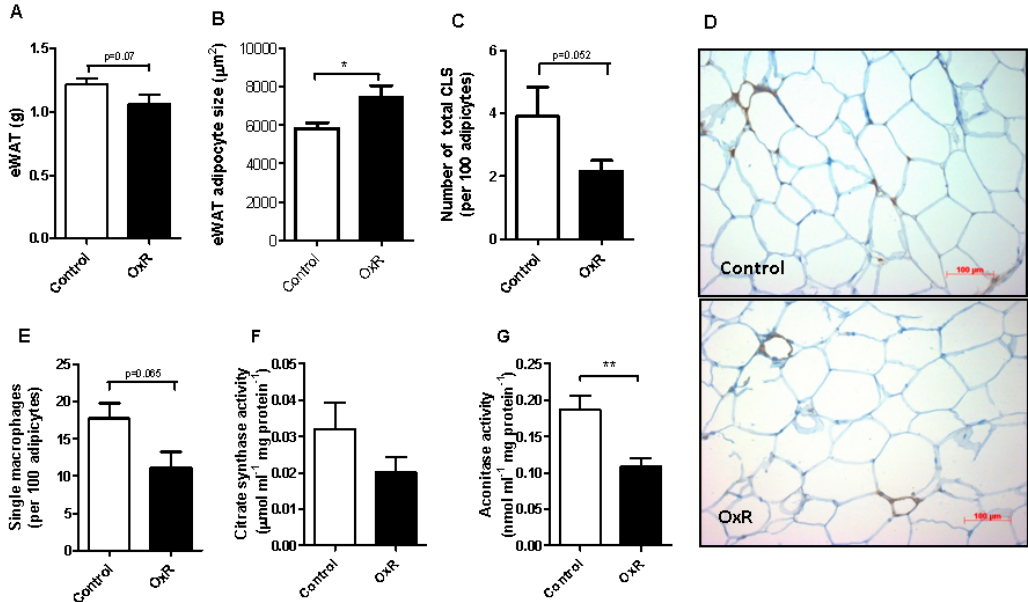
Figure 3. White adipose tissue (WAT) histology and inflammation. Epididymal white adipose tissue ( A ) weight, ( B ) mean adipocyte cell area, ( C ) number of crown-like structures (CLS) assessed by quantification of MAC-2 staining in Control and Oxygen restriction (OxR) mice (n = 12), with ( D ) representative pictures illustrating levels of CLS in Control and OxR-exposed mice. ( E ) number of single macrophages. ( F ) Citrate synthase (n = 6–7) and ( G ) aconitase activity (n = 10) in eWAT. Data are shown as mean ± SEM; * p < 0.05, ** p < 0.01.